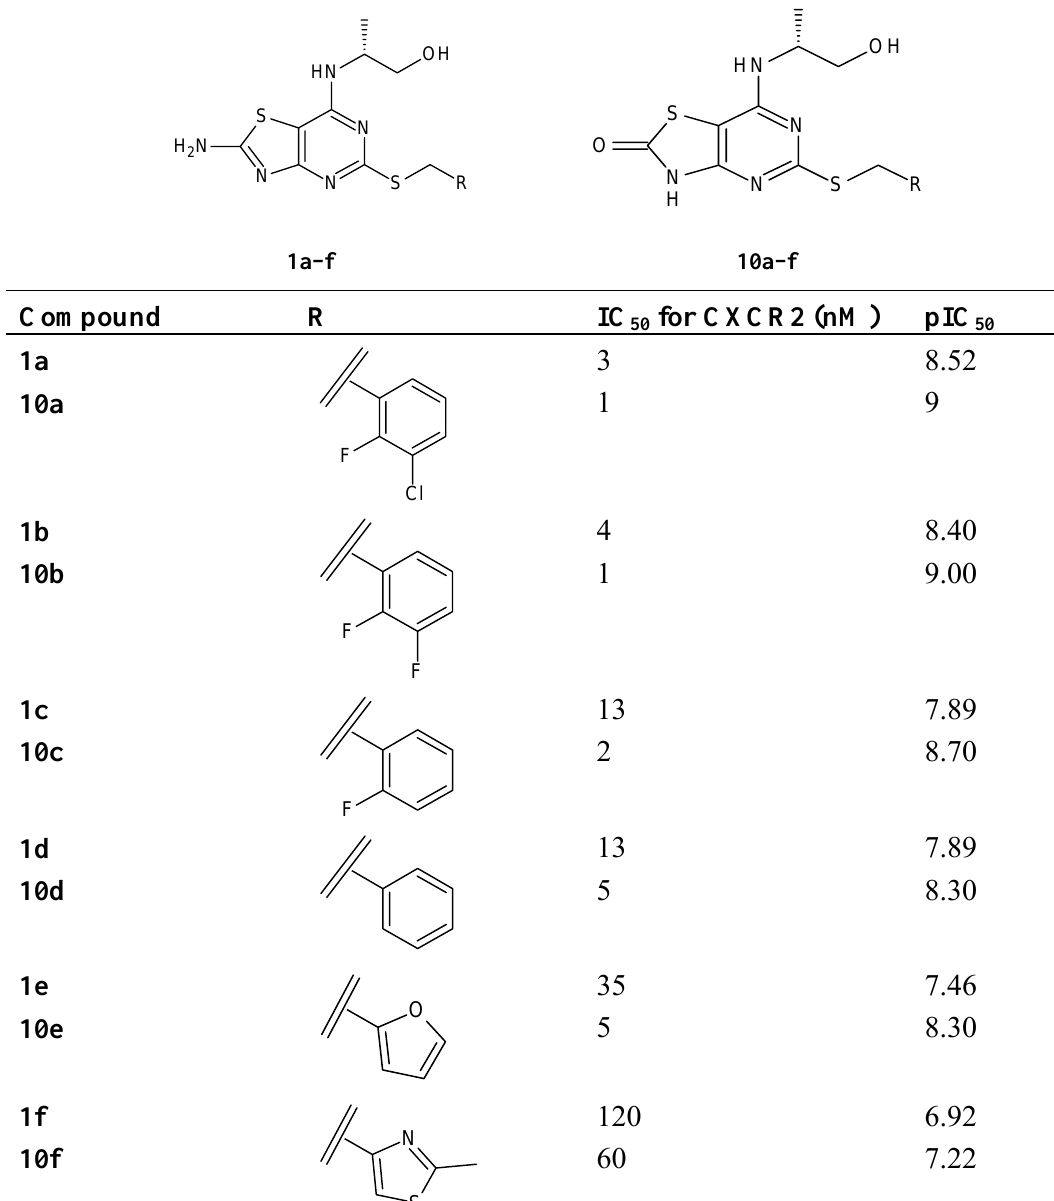
Table 7. Structures and biological activities of the bicyclic CXCR2